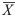
The VSI synthetic X¯ chart for the flow width measurements.This chart is used to monitor the flow width measurements (in micrometres, μm) for the hard-bake process. The chart signals an out-of-control at the 15th sample which corresponds to the 17th hour from the start of the process.